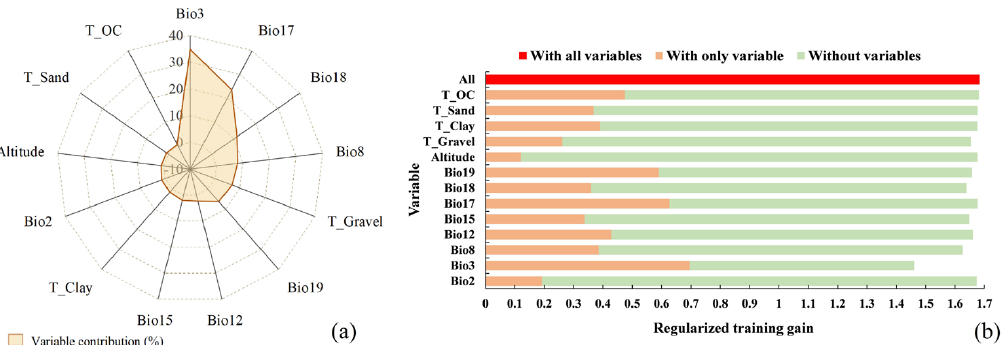
Figure 2. ( a ) Contributions of 13 environmental variables (Bio2: Mean Diurnal Range; Bio3: Isother- mality; Bio8: Mean Temperature of Wettest Quarter; Bio12: Annual Precipitation; Bio15: Precipita- tion Seasonality; Bio17: Precipitation of Driest Quarter; Bio18: Precipitation of Warmest Quarter; Bio19: Precipitation of Coldest Quarter; Altitude; T_Clay: Topsoil Clay Fraction; T_Gravel: Topsoil Gravel Content; T_Sand: Topsoil Sand Fraction; T_OC: Topsoil Organic Carbon); ( b ) Jackknife method results for the environmental variables of Tagetes minuta .